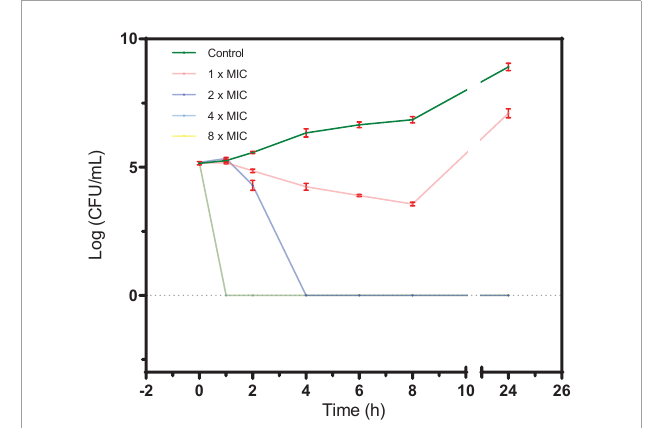
FIGURE1 A time-kill curve of S2303 against Staphylococcus aureus ATCC BAA 41. S. aureus BAA 41 was grown in Cation adjusted Müller–Hinton Broth (CAMHB) and spread on Trypticase Soy Agar (TSA) plates for CFU counts. S2303 [1 × MIC (pink), 2 × MIC (dark blue), 4 × MIC (light TABLE 2 MIC of S2303 used in combination with Polymyxin B nonapeptide blue), and 8 × MIC (yellow)] or Dimethyl sulfoxide (DMSO) [1% (v/v) (PMBN) against Escherichia coli ATCC 25922. (dark green)] was added to the cell cultures (5 × 10ˆ5 CFU/mL) at the start of the experiment (time zero), and the cultures were processed Compounds MIC ( µ g/mL) as described in the text. Time-kill curves of cells treated with 4 × MIC (light blue) and 8 × MIC (yellow) S2303 overlays and appear as a light E. coli ATCC 25922 green line in the plot. The MIC of S2303 against BAA 41 was 8 µ g/mL. This result is representative of three independent experiments. Error Polymyxin B nonapeptide (PMBN) bar is in color of red. When no cells grow, the number of cells is regarded as 1 for calculating log (CFU/mL)